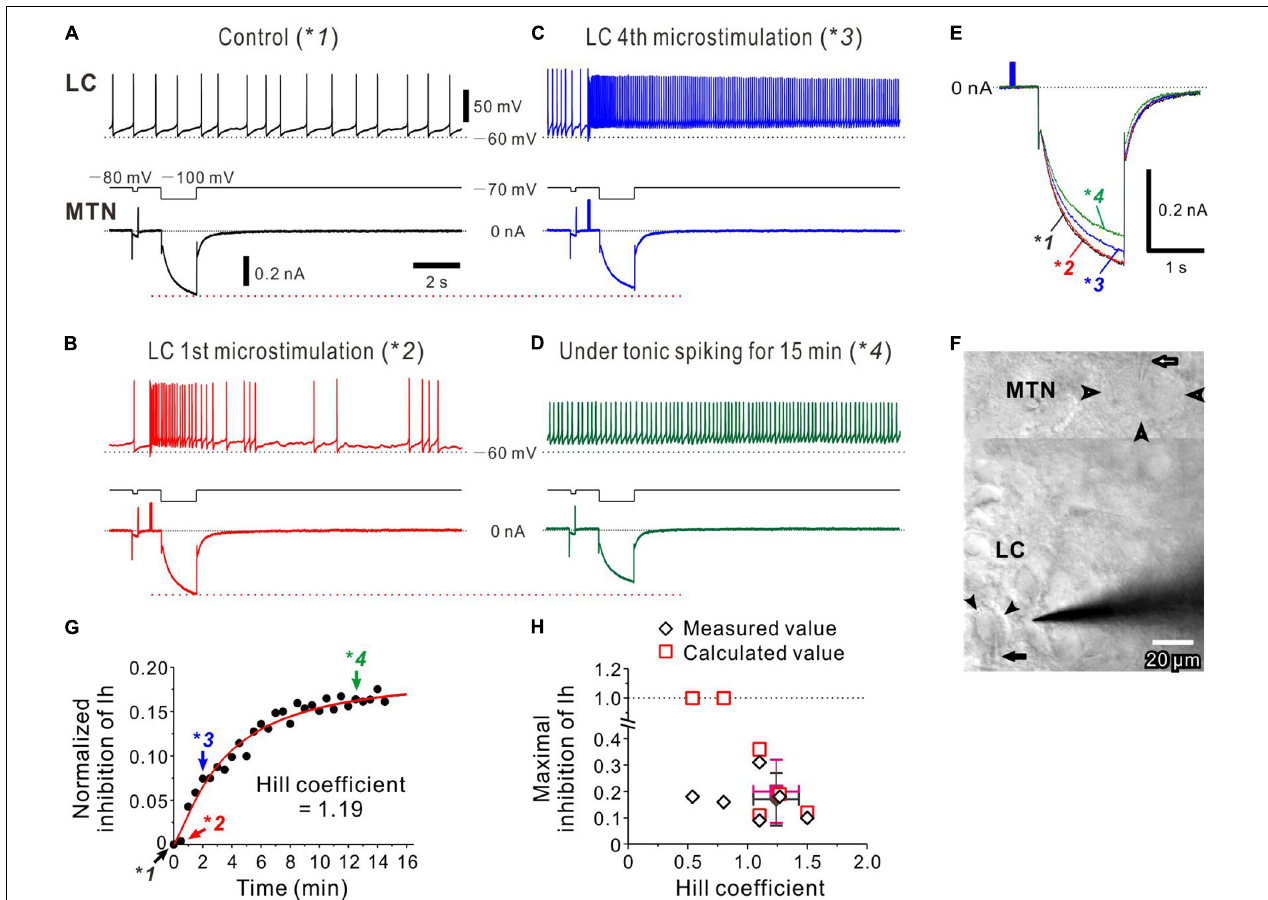
FIGURE 4 | Noradrenaline (NA) volume transmission from multiple LC neurons to an MTN neuron. (A) Occurrence of spontaneous firing approximately at 0.8 Hz in an LC neuron, during which Ih was induced in an MTN neuron (* 1 ). (B) The 1st microstimulation of LC inducing a transient increase in spike firing in the LC neuron without causing no marked inhibition of Ih evoked in the MTN neuron (* 2 ). (C) The 4th microstimulation of LC inducing a persistent increase in spike firing and causing an apparent inhibition of Ih (* 3 ). (D) Tonic spike firing approximately at 5–7 Hz in the LC neuron, causing a further inhibition of Ih (* 4 ). (E) Superimposed traces of Ih responses indicated with * 1 , * 2 , * 3, and * 4 in (A–D) . (F) A composite photomicrograph; the upper and lower parts taken at a superficial focal plane to show an MTN neurons (open arrowheads) and at a deeper focal plane to show an LC neuron (filled arrowheads), respectively, from which dual whole-cell recordings were performed while microstimulation was applied to LC. Arrows indicate patch pipettes. (G) Plotting of time and normalized inhibition of Ih. Plots indicated with * 1 , * 2 , * 3, and * 4 were obtained from results shown in (A–D) . The red curve was obtained by the Hill equation fitting to the data points. (H) Plotting of maximal inhibition of Ih against nH and ( n = 6). Filled diamond and square indicate mean values of nH and maximal inhibition in measured (open diamonds) and calculated (open squares) values, respectively.